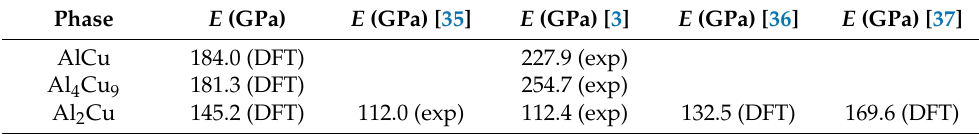
Table 2. The elastic modulus (E) of the three phases: DFT calculation and experiment (exp).